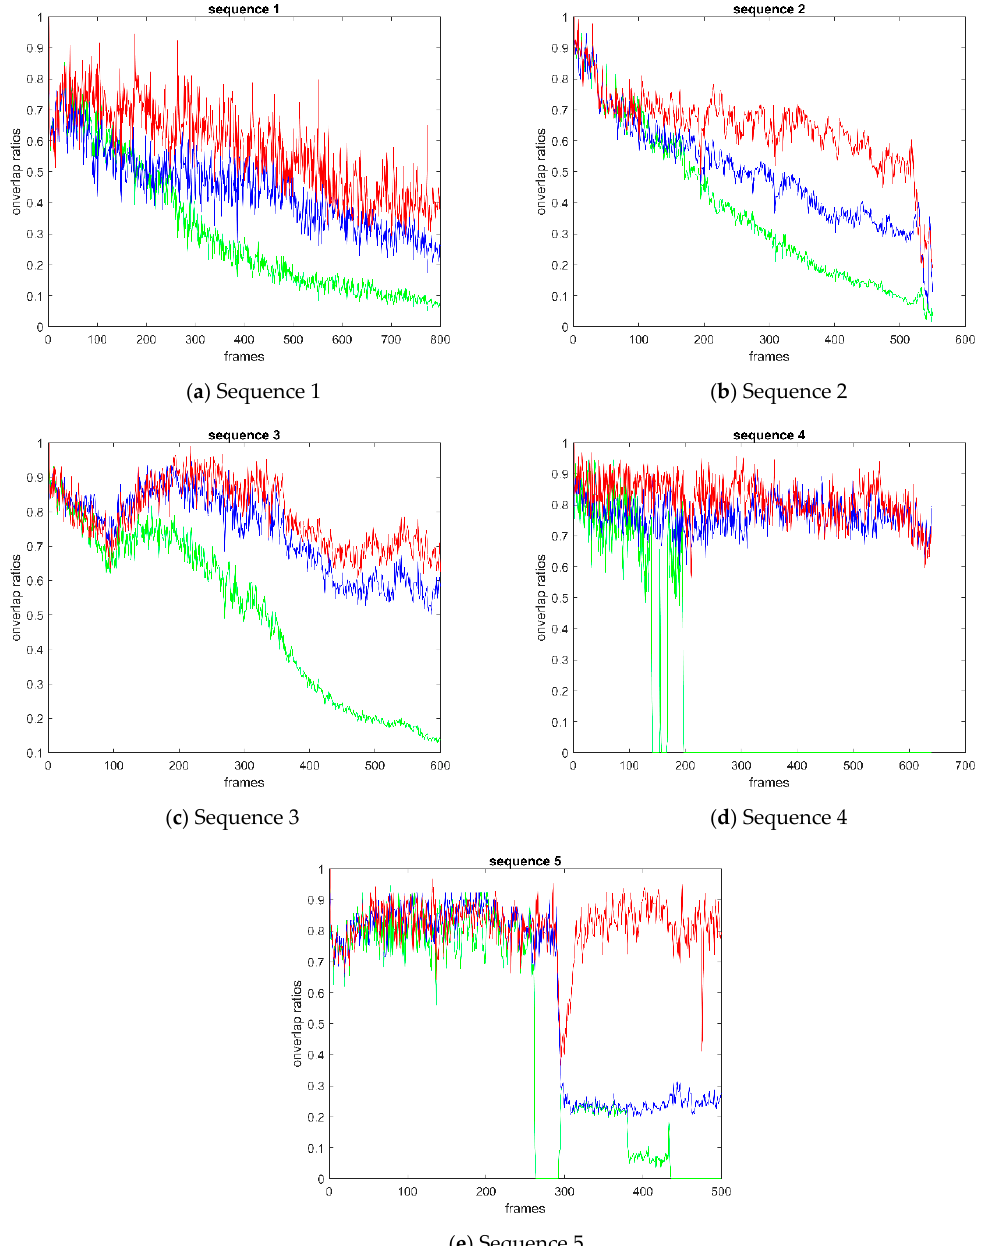
Figure 9. Curve of overlap ratio between predicted box and real box: ( a ) sequence 1; ( b ) sequence 2; ( c ) sequence 3; ( d ) sequence 4; ( e ) sequence 5. The points on the curves indicate the overlap ratio between the predicted bounding box and the ground-truth bounding